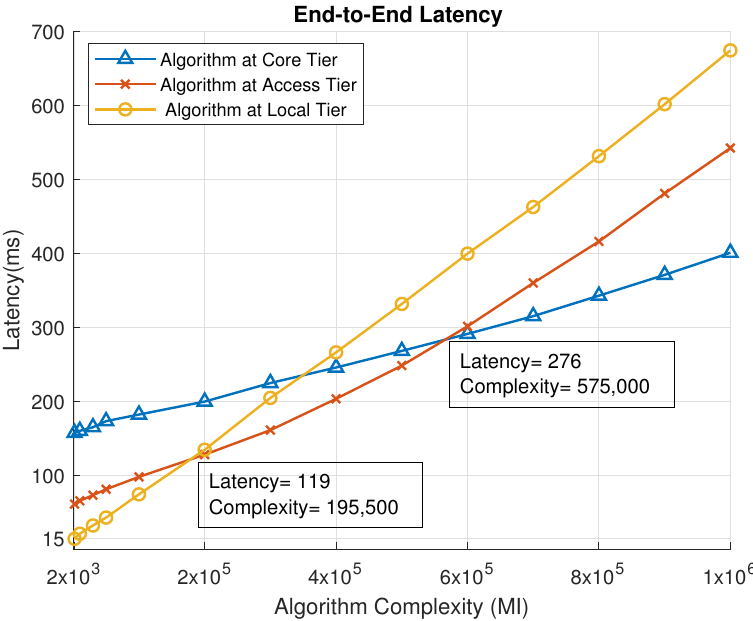
Figure 5. End-to-end latency: with the blockchain